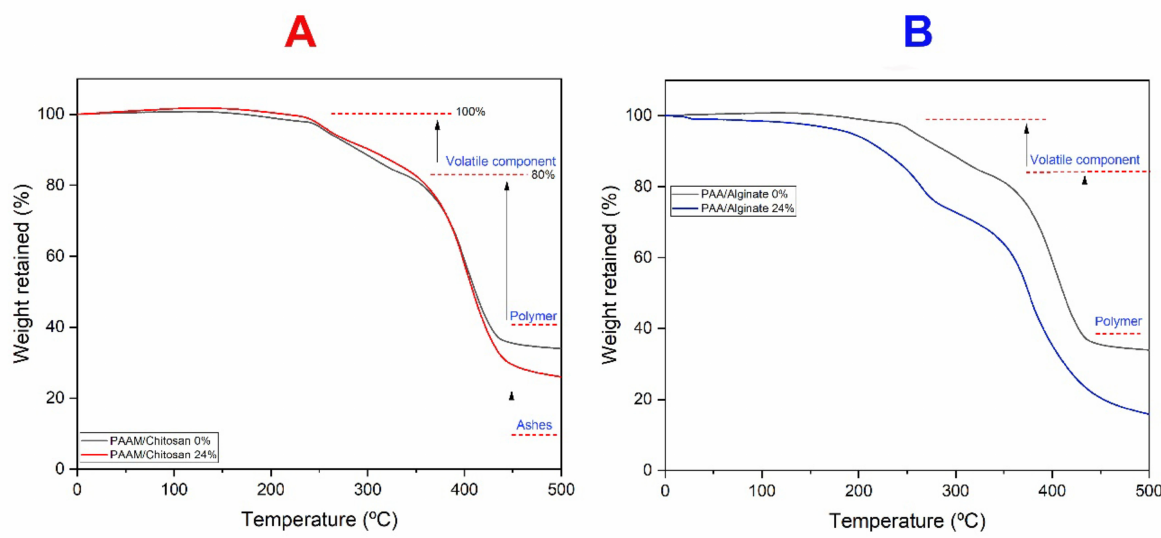
Figure 6. Thermogravimetric analysis (TGA) of ( A ) PAAM/chitosan xerogels and ( B ) PAA/ alginate